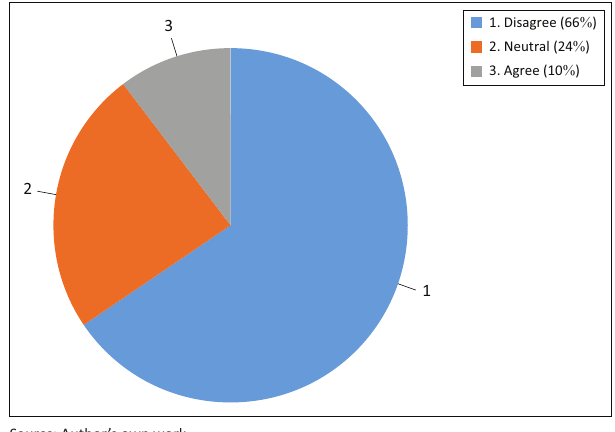
FIGURE 4: Students’ views on the adequacy of the multilingual strategies and interventions they have been exposed to: The multilingual teaching and learning strategies and interventions you have been exposed to are adequate ( % )